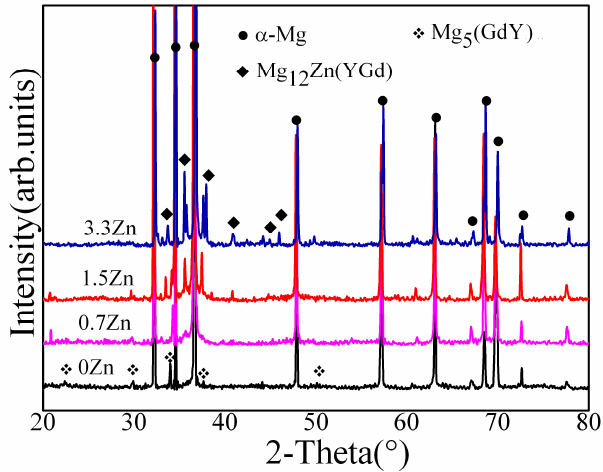
Figure 3. XRD patterns of the experimental alloys.